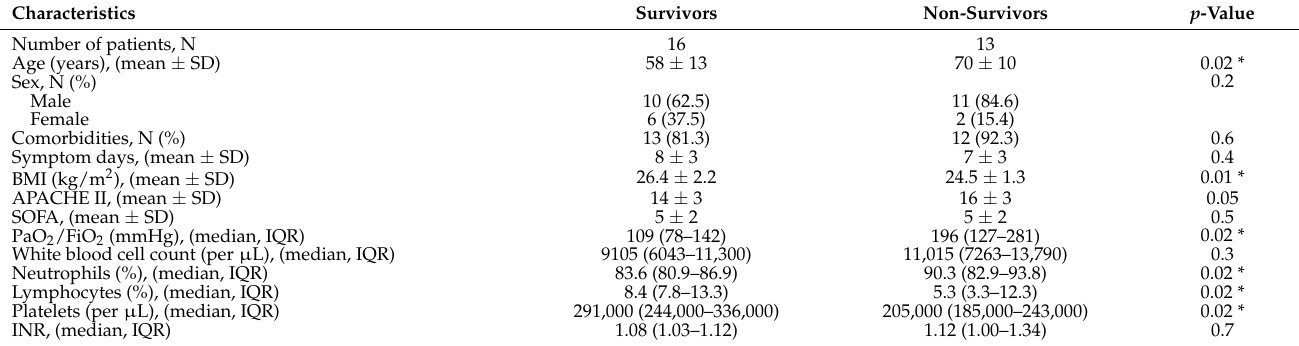
Table 3. Demographics, clinical characteristics and biomarkers on ICU admission in the dexamethasone-treated group.